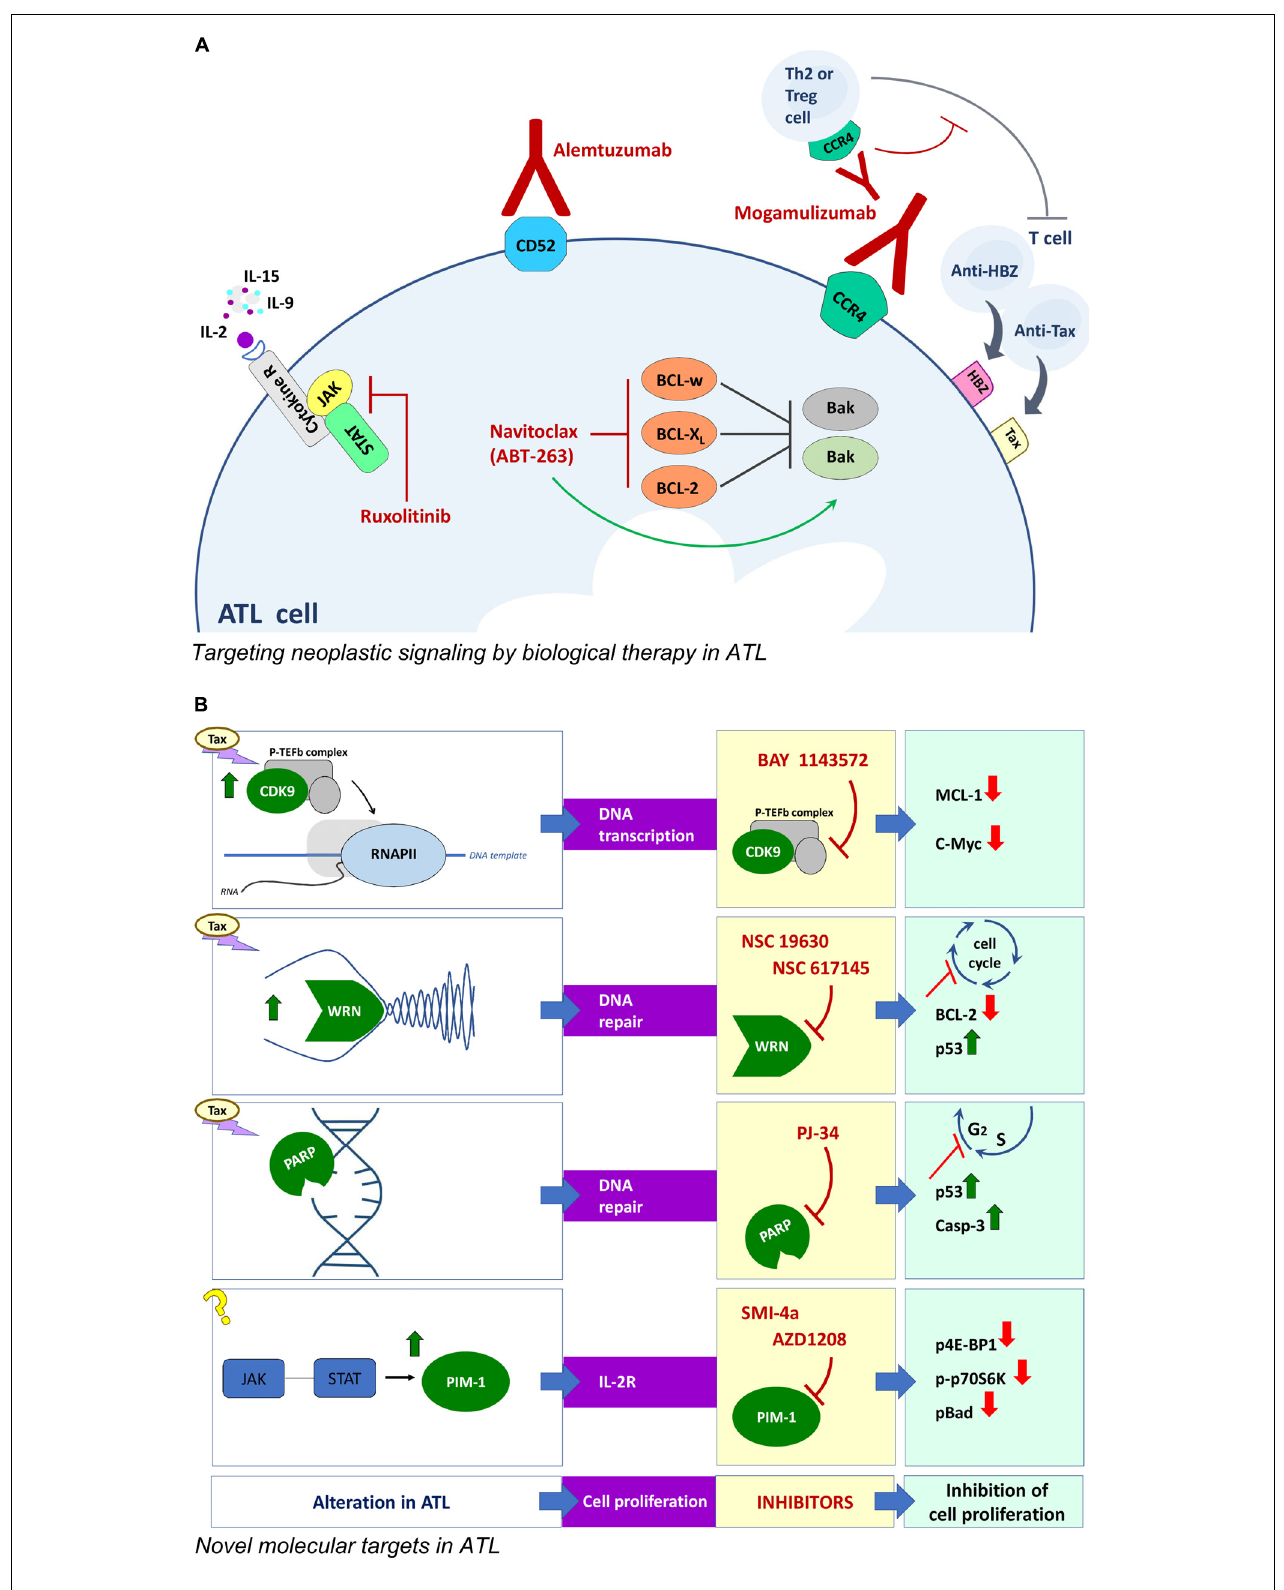
FIGURE 2 | Novel approaches for ATL therapy. (A) Biological therapy with monoclonal antibodies and corresponding targets involved in neoplastic signaling in ATL cells. (B) Compounds and corresponding targets potentially useful for innovative targeted therapies in ATL.